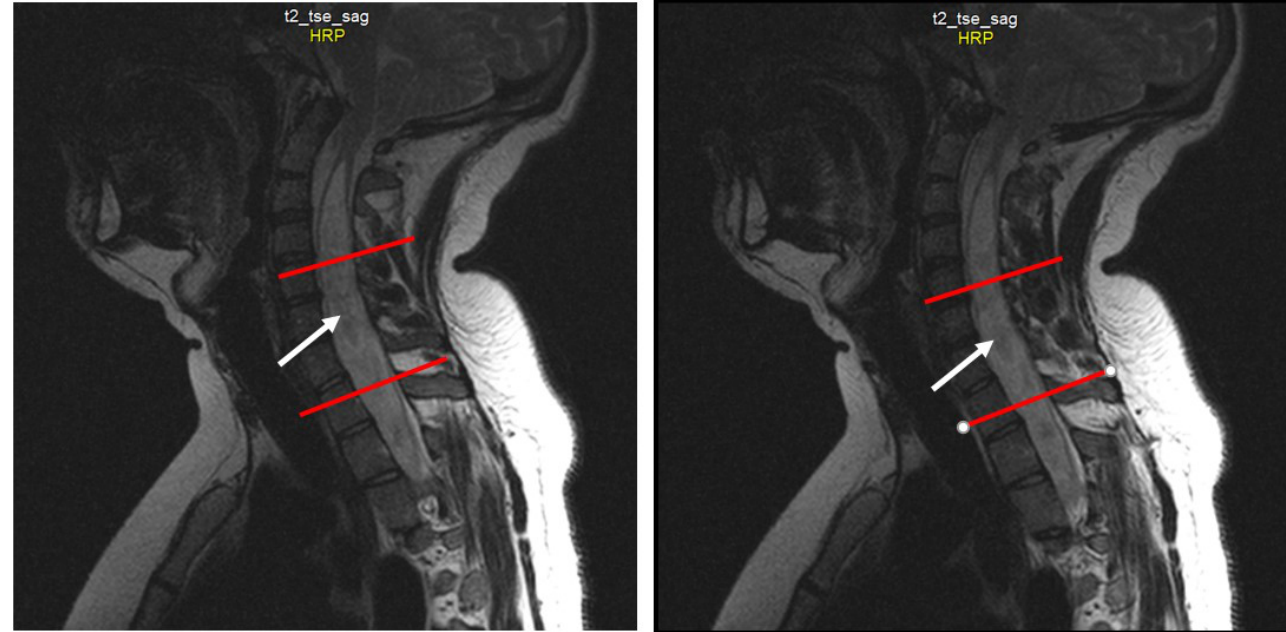
Figure 2. Sagittal T1-weighted MRI scans of the brain: caudal descent of the cerebellar tonsils 6 mm (white arrow) below the McRae line (red line).